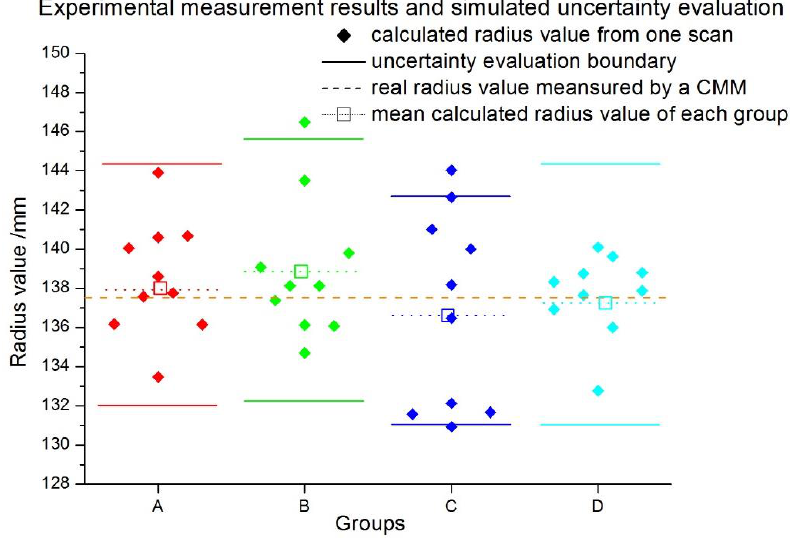
Figure 10. Experimental radius measurement results and simulated uncertainty evaluation results.